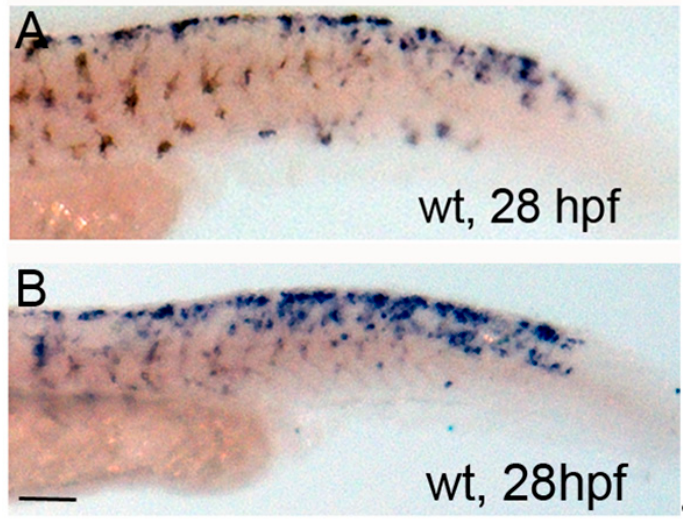
Figure 4. Forskolin treatment expands mitfa expression at 28 hpf. ( A , B ) Brightfield images of lateral tail regions of 28-h-old wildtype control and forskolin-treated embryos processed for in situ hybridization using mitfa probe. Note increased mitfa expression in the dorsal tail. Scale bar = 100 um and applies to both images.